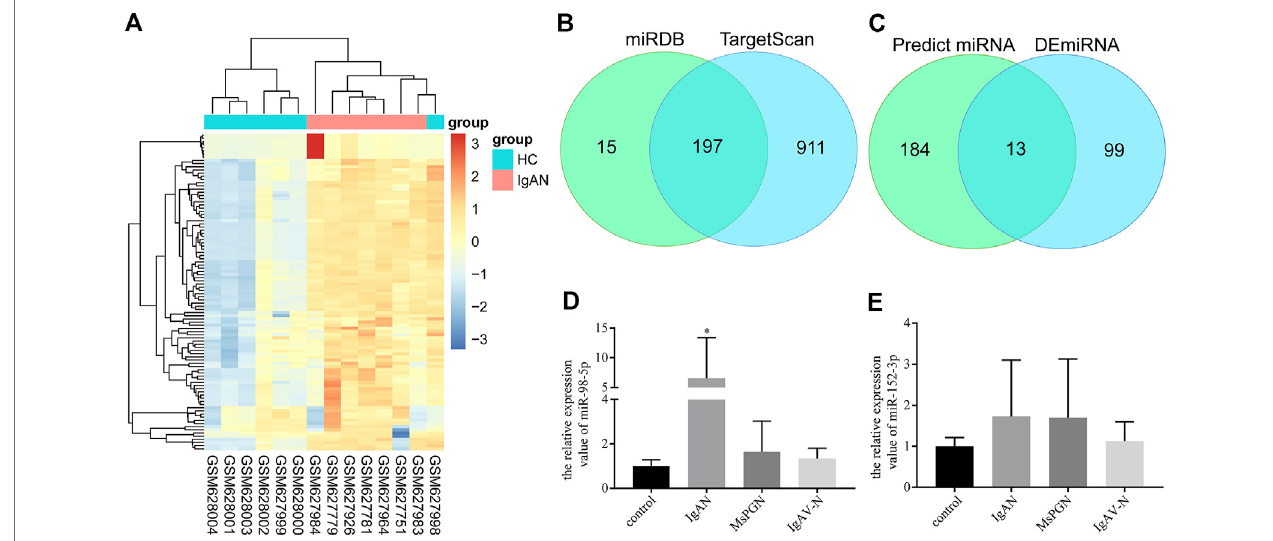
FIGURE 1 | miRNA screening and validation. (A) Heatmap of DEmiRNAs in GSE25590. Red and blue: upregulated and downregulated. Columns represent different samples, rows indicates different genes. Signi fi cantly differential miRNA were de fi ned by |log 2 (FC)| > 1 and p -value < 0.05. (B) Venn diagram showing the intersection miRNAs predicted by TargetScan and miRDB. (C) Venn diagram showing the intersection of DEmiRNAs and predicted miRNAs. (D) Validation of the differentialexpressionofmiR-98-5pinPBMCsamongpatientswithIgAN,healthycontrols,patientswithMsPGN,andpatientswithIgAV-N(thefoldchangeofIgAN vs. healthy control, MsPGN and IgAV-N were 6.60 ± 6.20 vs. 1.00 ± 0.26, 6.60 ± 6.20 vs. 1.64 ± 1.26 and 6.60 ± 6.20 vs. 1.35 ± 0.42, respectively, all p < 0.05). (E) Validation ofthedifferential expression ofmiR-152-3pamongdifferent groups. Each bar representsthemean ± SDofsixcases ineach group. Compared withtheother groups, * p < 0.05. Note: DEmiRNA, differentially expressed miRNAs; FC, fold change; PBMCs, peripheral blood mononuclear cells; IgAN, IgA nephropathy; MsPGN, mesangial proliferative glomerulonephritis; IgAV-N, immunoglobulin A vasculitis nephritis; SD, standard